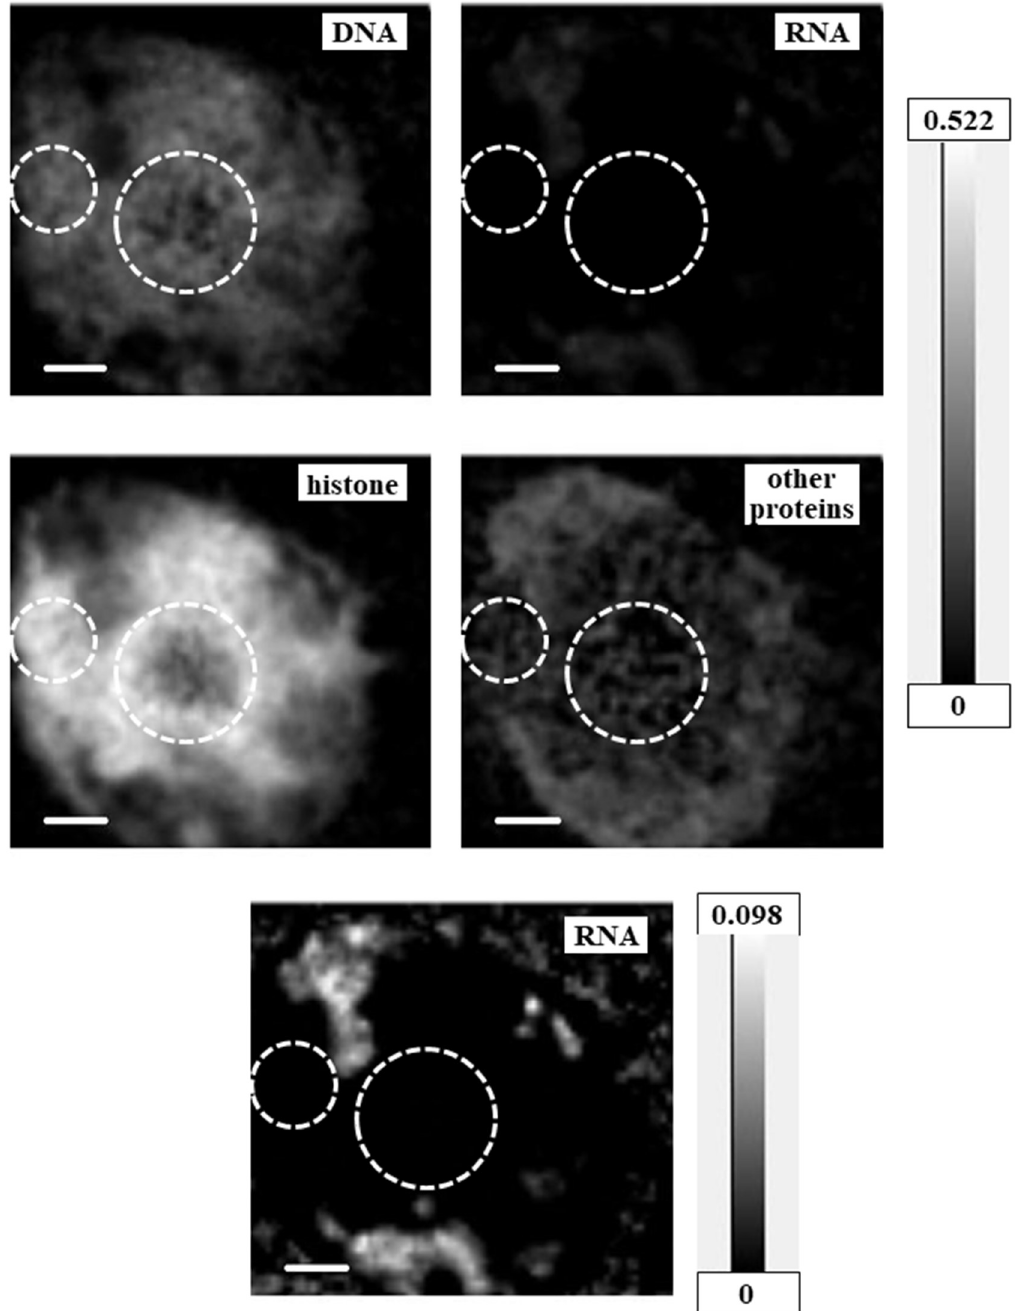
Figure 7. Mass thickness images for DNA, RNA, histone, and proteins other than histone of the apoptotic nucleus. Grayscales on the right represent units of pg/ µ m 2 —scale is consistent for the top four images, and different for the bottom image to show the distribution of RNA more clearly. Scale bars represent 1 µ m. Areas possibly unreliable for the analysis are encircled with dashed lines.